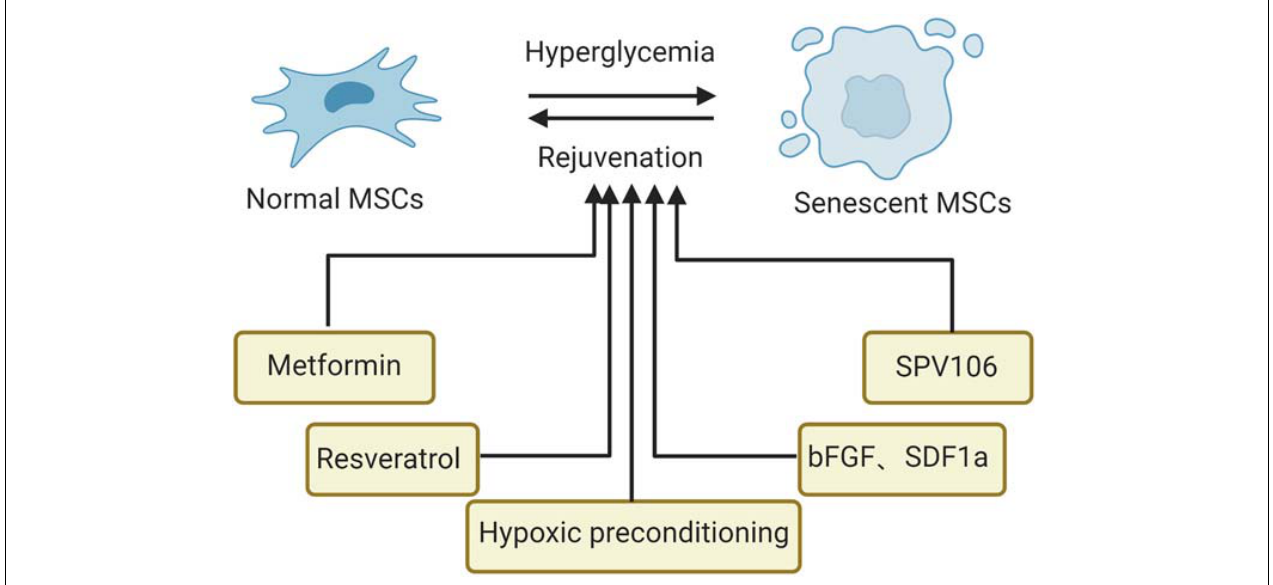
FIGURE 3 | Strategies to suppress senescence of MSCs in the hyperglycemic microenvironment. SCD1, stearoyl-coenzyme A desaturase-1; bFGF, basic fibroblast growth factor; SPV106, histone acetylase activator pentadecylidenemalonate 1b.